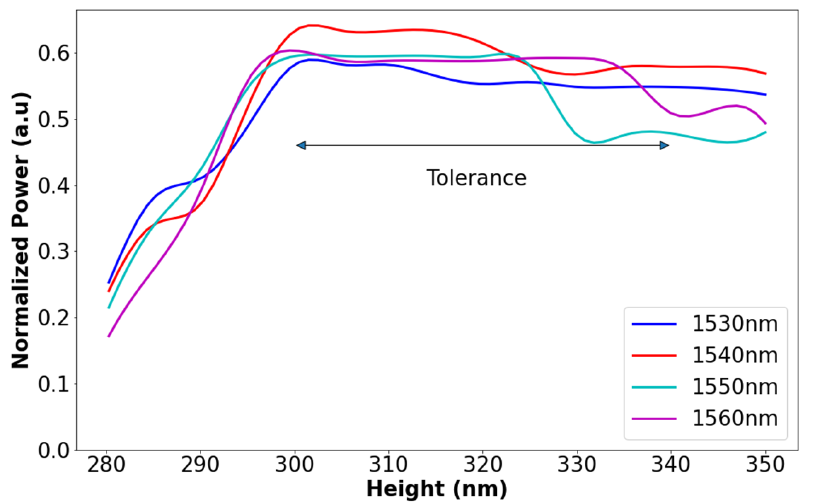
Figure 3. Normalized power as a function of strip height (SiN).